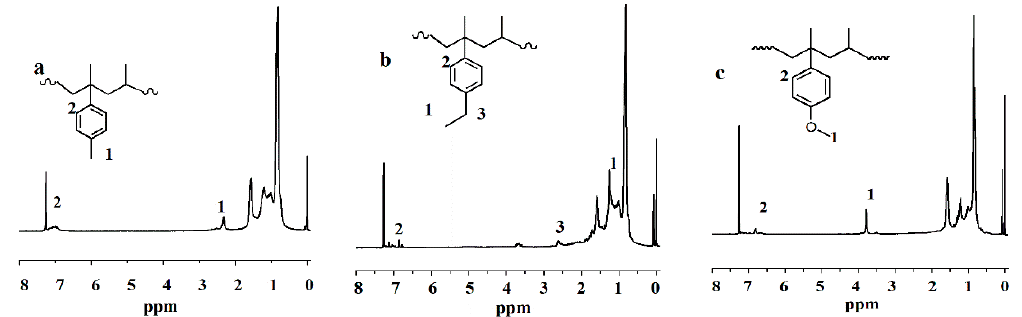
Figure 2. 1 H-NMR spectra of propylene- co -styrenic monomer copolymers represented by tertiary carbon linkage: ( a ) P1, ( b ) P2, ( c ) P3.